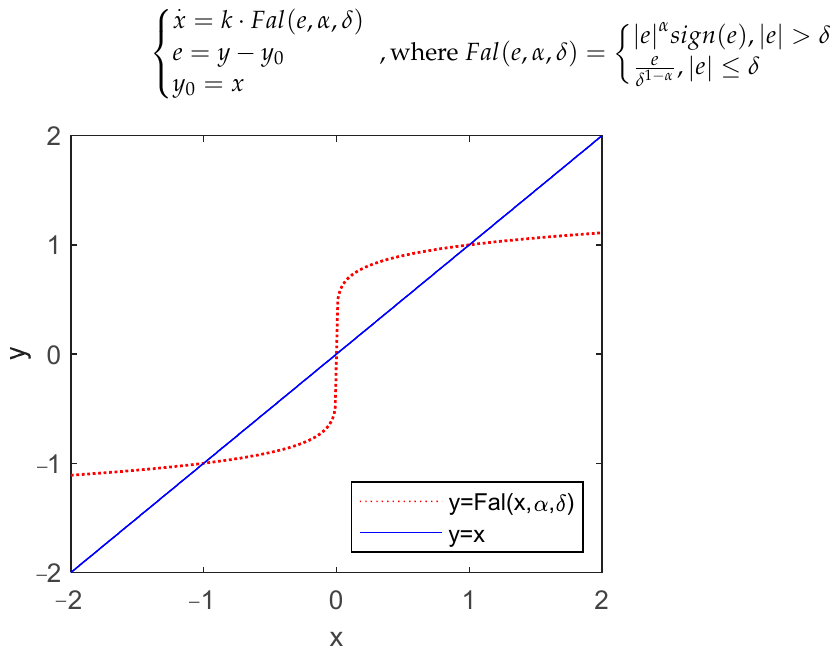
Figure 9. Fitting schematic diagram of Fal function. A comparison of unit step response with band-limited white noise power of 0.003 between the system with the filter and the system without the filter is executed to validate the performance of the Fal function filter. The filter parameters are: k = 1000, δ = 0.8, α = 0.5. Figure 10 shows the error comparison for the filter performance. The standard deviation of the error between the reference input and the actual system output are 0.1721 ◦ and 0.0612 ◦ , respectively. The result shows that this Fal function filter has a good performance of state tracking for the system with noise.